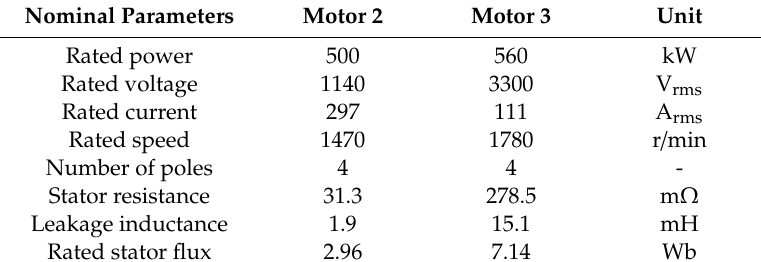
Table 3. Manufacturer data for induction motors used in the experiments.